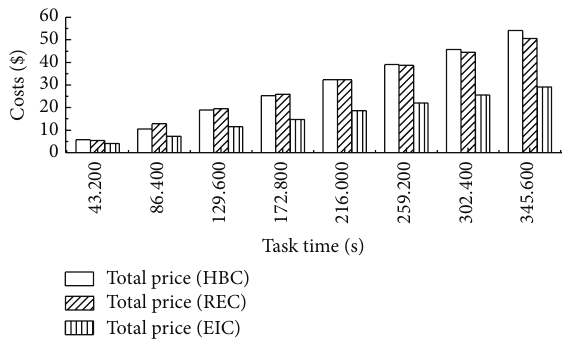
Figure 21: Comparison of total